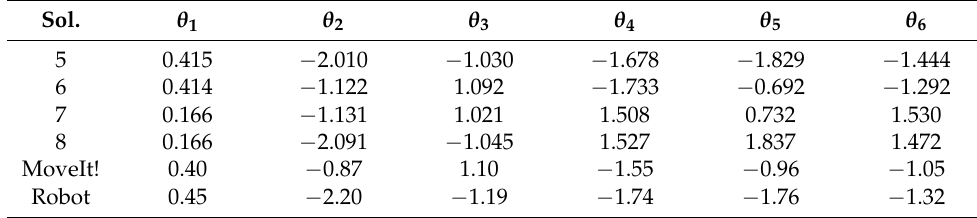
Table 6. Feasible solutions to example no. 2 (in